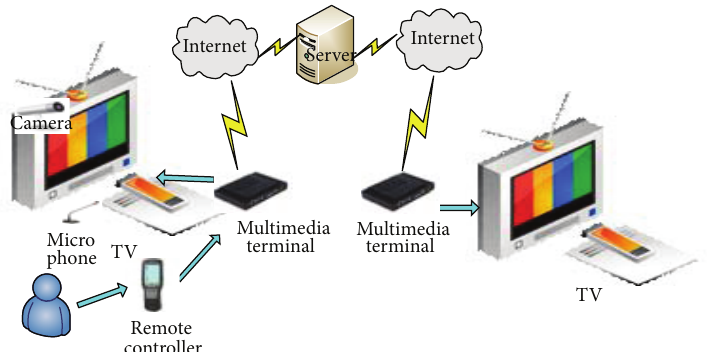
Figure 1: Overview of the whole videophone